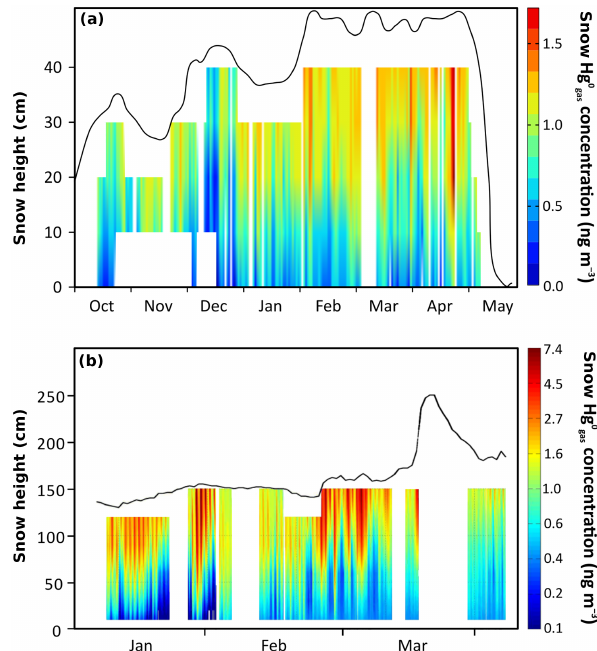
Figure 3. Gaseous Hg 0 concentration profiles in snowpack intersti- tial air during the snow-covered season from October 2014 to May 2015 over the Arctic tundra measured at Toolik Field Station based on continuous observations at up to five heights in the snowpack each hour, and interpolation of these data across the entire snow- pack (a) . Missing data in the lower snowpack in 2014 were due to line freezing of the lowest inlet. For comparison, interpolated Hg 0 gas concentration profiles in snowpack interstitial air during the snow- covered season based on similar measurements at Niwot Ridge, Rocky Mountains, Colorado, USA, during the winter of 2009 (b) (adapted with permission; Faïn et al.,